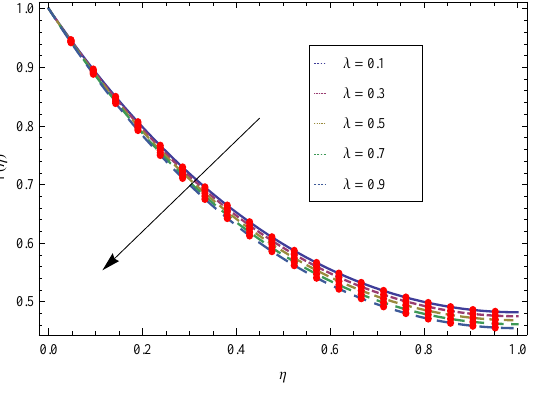
Figure 7. Variations in the Concentration field φ ( η ) for different values of S , when h = − 0.6, λ = 0.5, kr = 0.5,Pr = 0.5,Ec = 0.5,Nb = 0.5,Nt = 0.6, β = 1, Sc = 0.6.